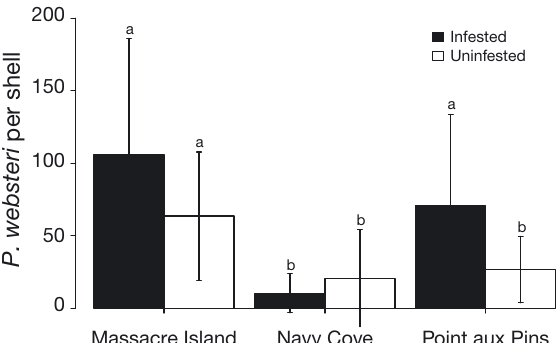
Fig. 8. Mean (±SD) Polydora websteri per oyster shell (n = 15) of previously infested and uninfested shells deployed at Massacre Island, Navy Cove, and Point aux Pins. Letters in- dicate significant differences (Tukey post hoc test, p <